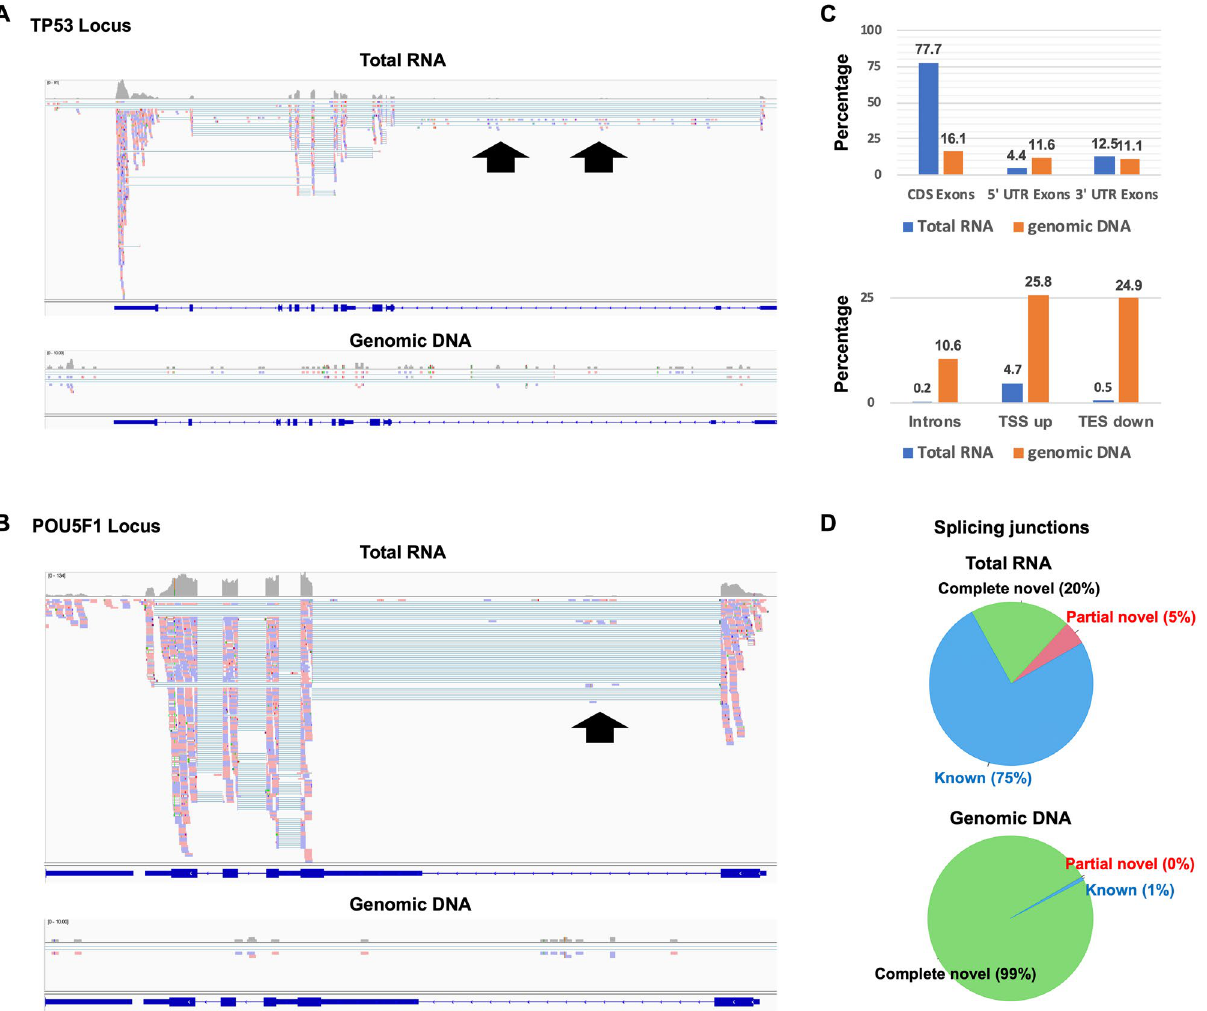
Figure 2. Confirmation of non-specific genomic DNA amplification from genomic DNA. ( A and B ) Integrative genomic viewer (IGV) of the TP53 and POU5F1 Locus mapped reads. Black arrows show non-specific genomic DNA amplification. ( C ) The percentage in each region (CDS Exons, 5’UTR Exons, 3’UTR Exons, Introns, TSS upstream (TSS up) and TES downstream (TES down)). ( D ) Pie chart of each splicing junction. The percentage of splicing events were calculated by